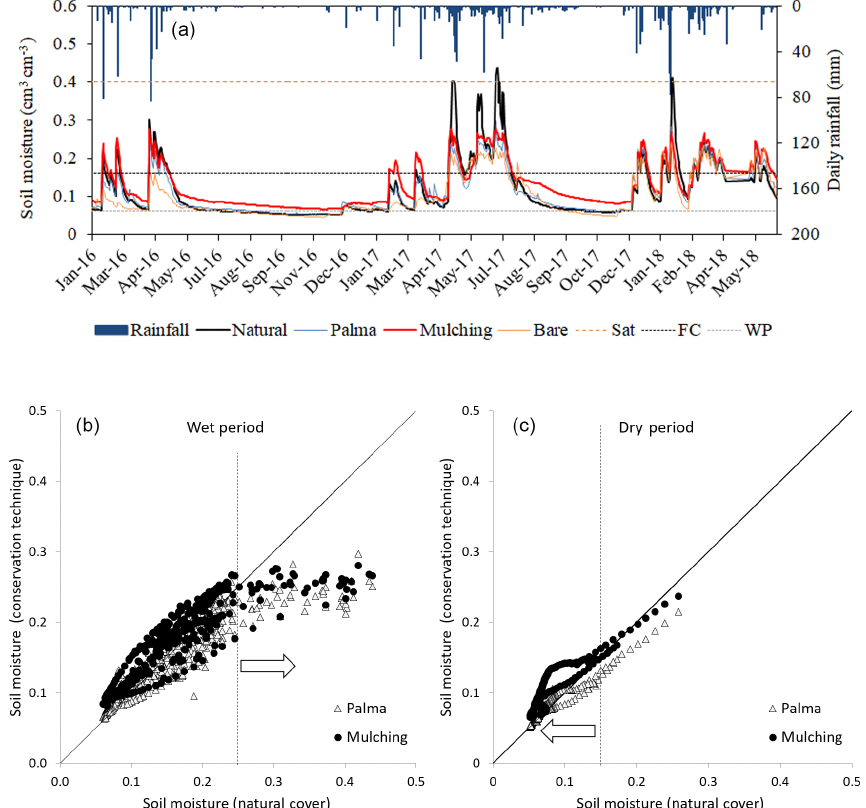
Figure 4. Time series for soil moisture, for native vegetation (Caatinga), Cactus barriers (Palma), mulching and bare soil, at the experimental plots, at site 1 (João), for the 0–0.20m layer (a) ; Comparison of soil moisture for different cover conditions with Caatinga (b, c) . Sat: Saturated soil moisture; FC: Field Capacity; WP: Wilting